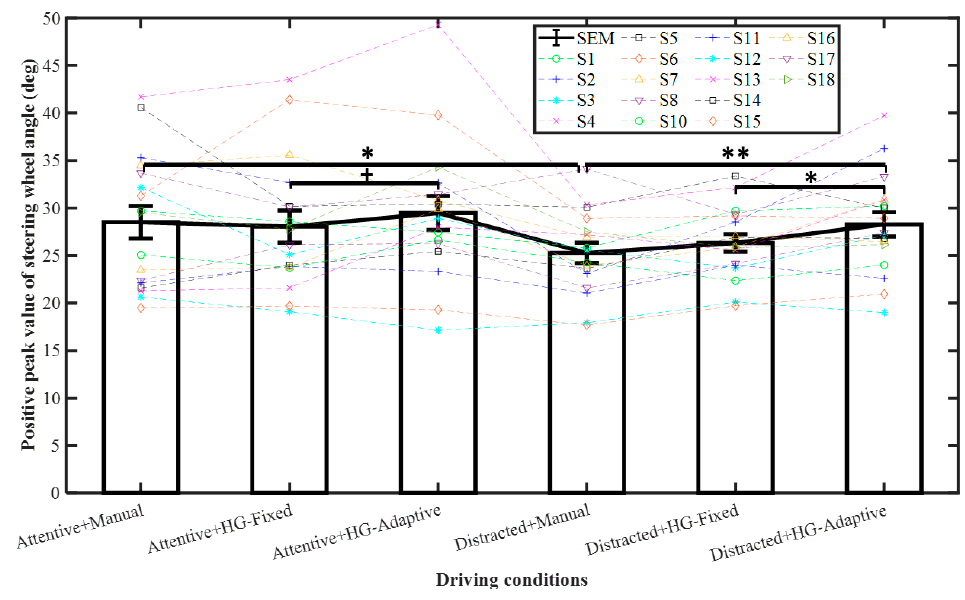
Figure 3. Peak value of SWA at the first lane change. Mean +/ − SEM (standard error of mean) represented by error bars. + p < 0.1, * p < 0.05, and ** p < 0.01.